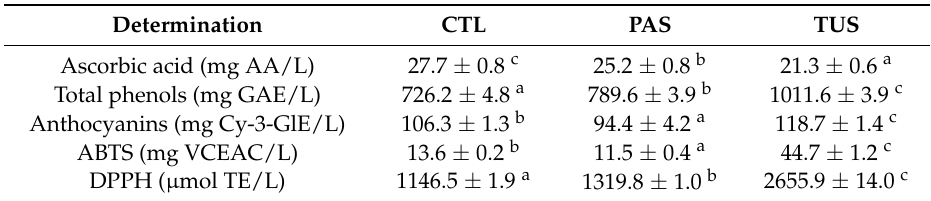
Table 1. Antioxidants content and antioxidant activity in blackberry